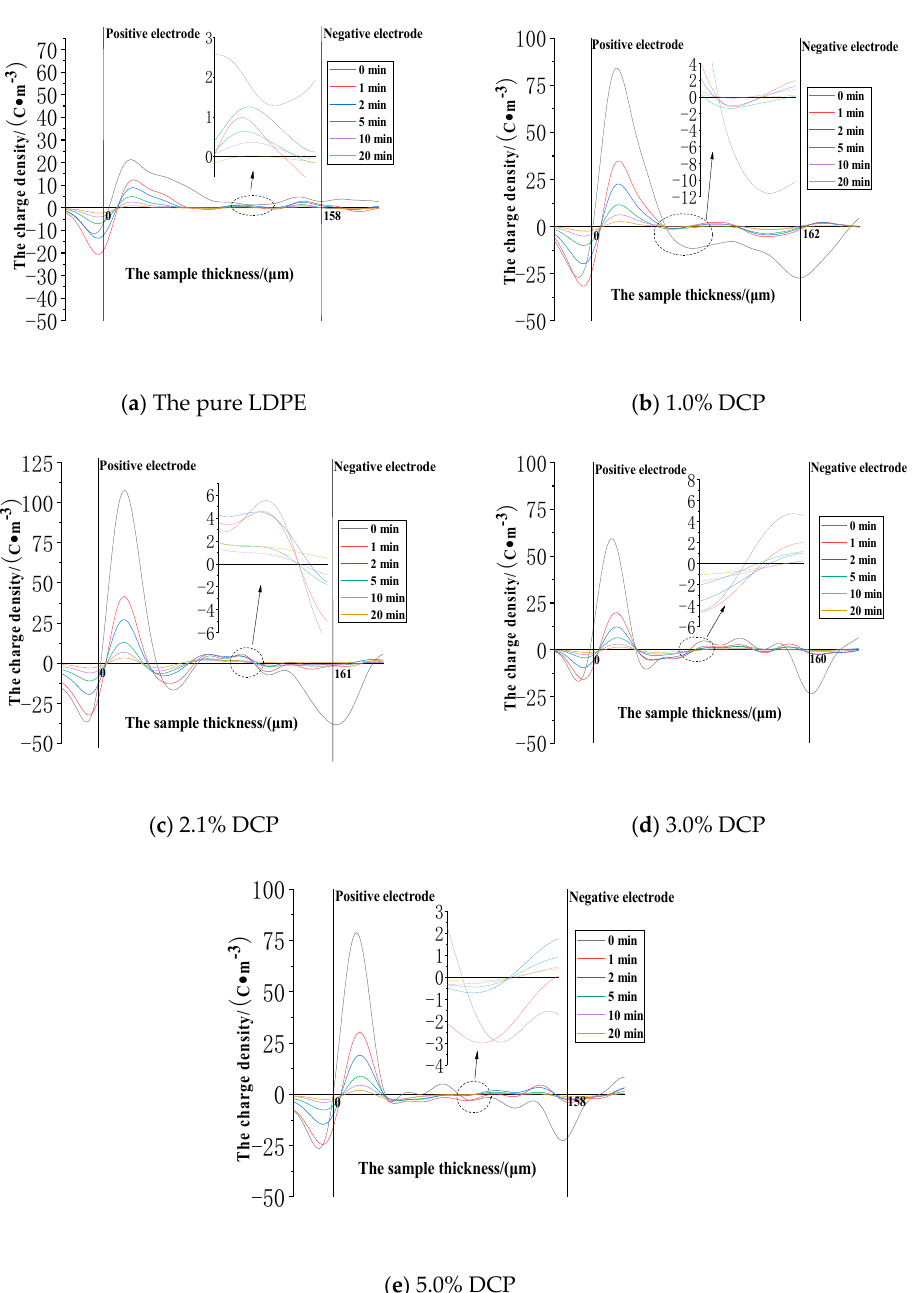
The space charge distribution in the removed voltage experiment after the action of 80 kV/mm is shown in Figure 9.